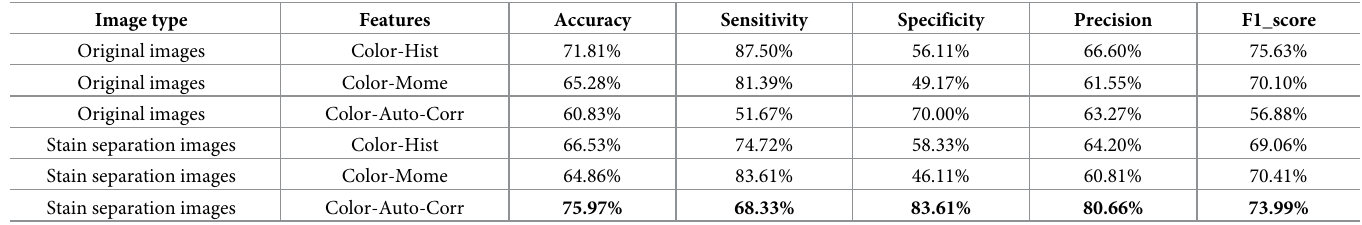
Table 3. Comparison of different color feature methods at